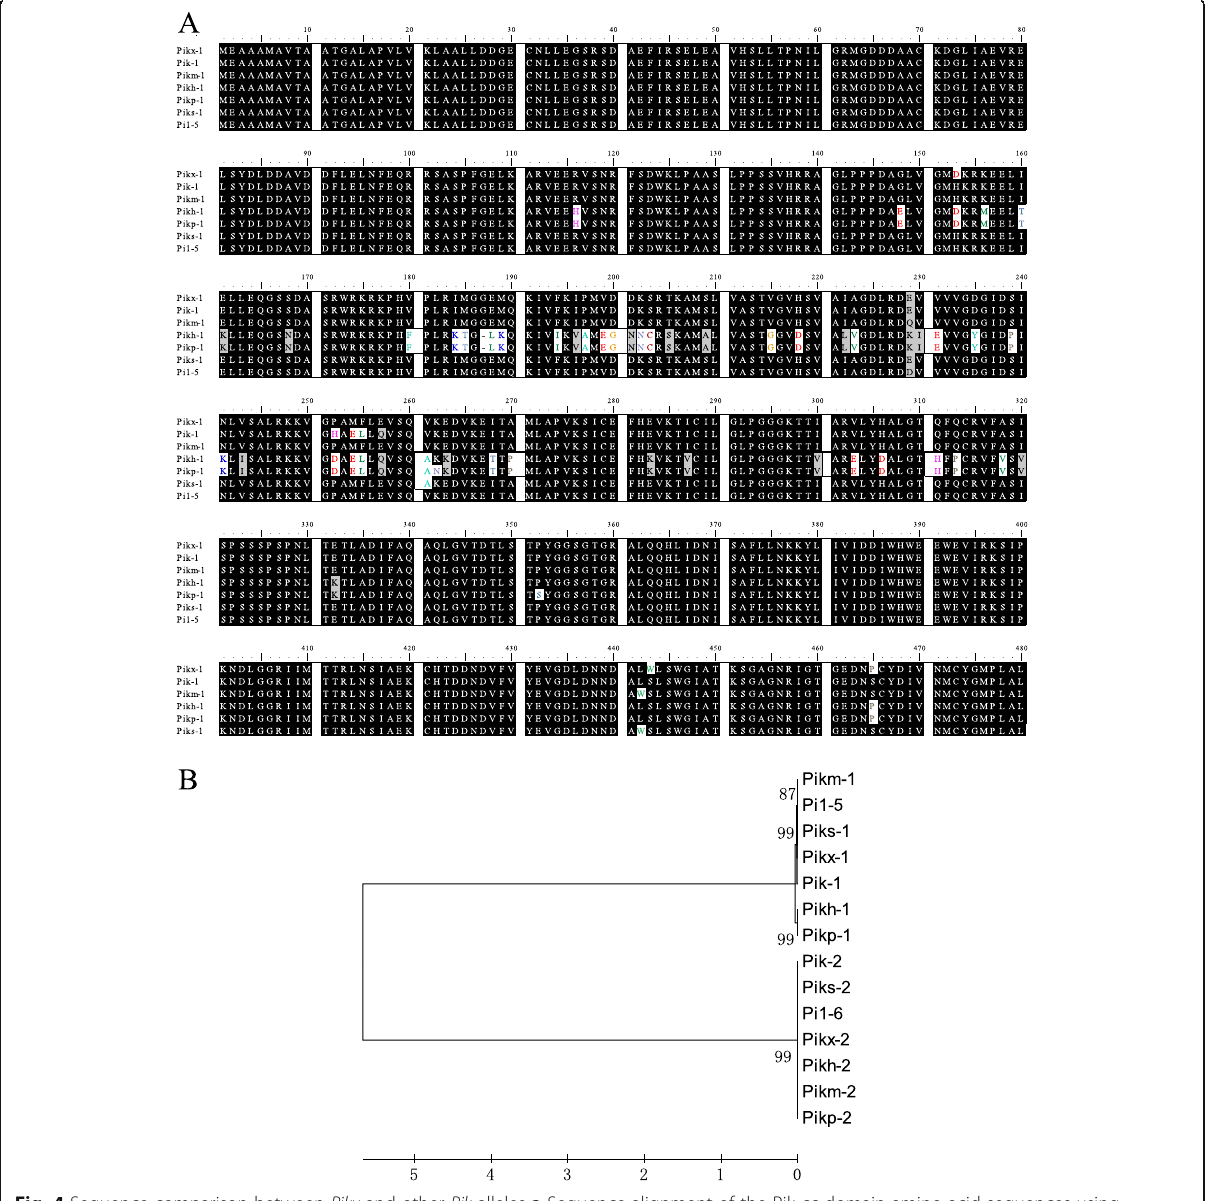
Fig. 4 Sequence comparison between Pikx and other Pik alleles a Sequence alignment of the Pik cc domain amino acid sequences using ClustalW. Shading fonts indicate common amino acid residues in the alleles. b Phylogenetic analysis of Pik allele protein sequences using MEGA 5. The tree was generated using UPGMA. Numbers stand for bootstrap values from 1000